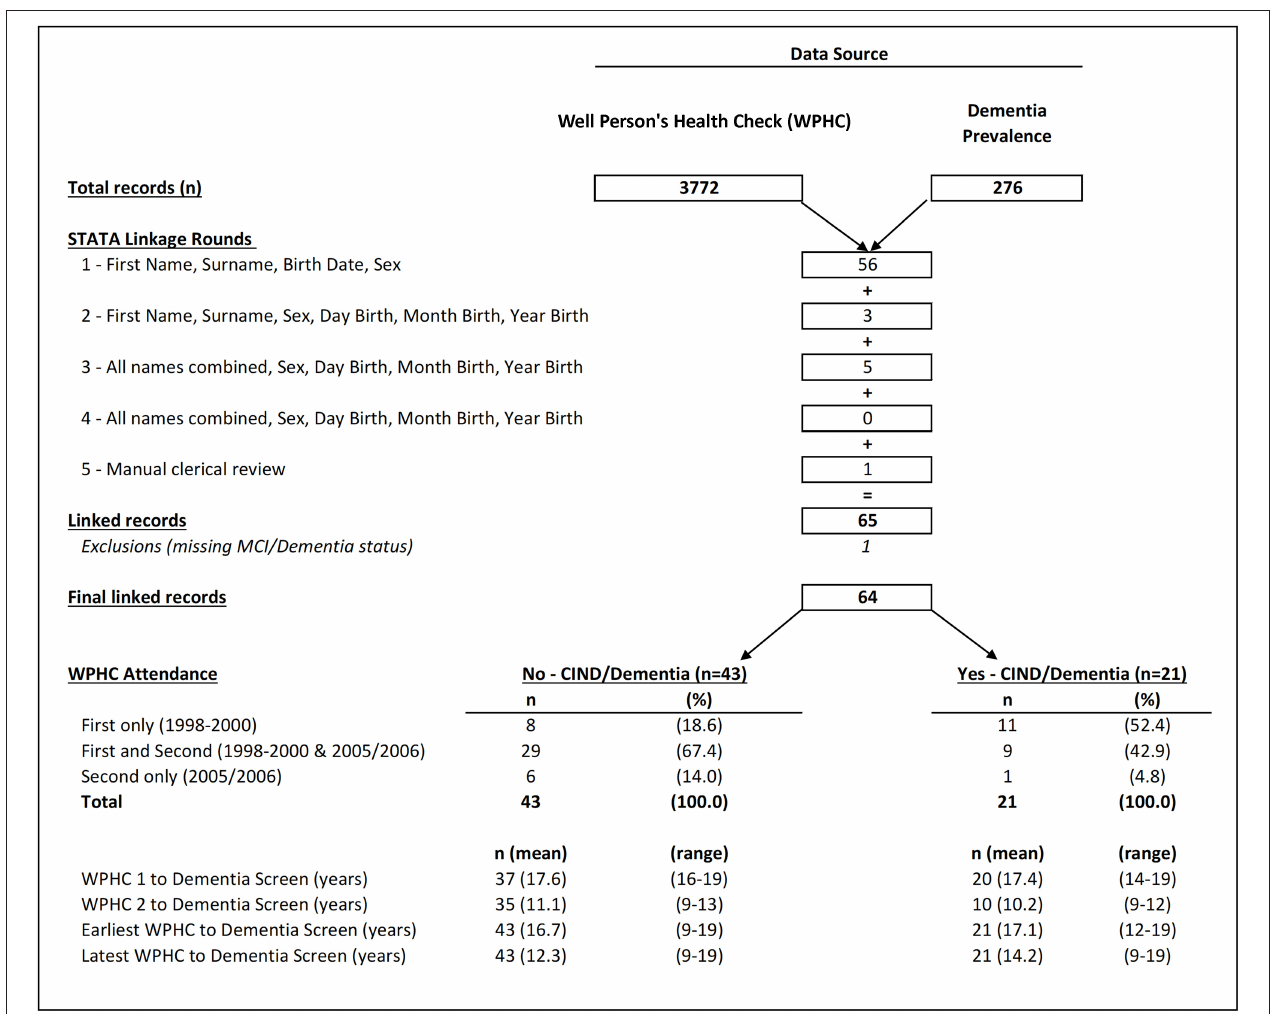
FIGURE 1 | Flowchart showing steps involved in probabilistic linkage of datasets from the Well Person’s Health Checks (WPHC) (1998/2000, 2005/2006) and the Dementia Prevalence Survey (2015–2018). CIND, Cognitive Impairment Not Dementia; WPHC1, First Well Person’s Health Check (1998–2000); WPHC2, Second Well Person’s Health Check (2005–2006); Earliest WPHC, Earliest recorded information from the first WPHC screen if the person attended, or the second screen if the person did not attend the first screen; Latest WPHC, Latest recorded information was from the second WPHC screen if the person attended, or the first screen if the person did not attend the second